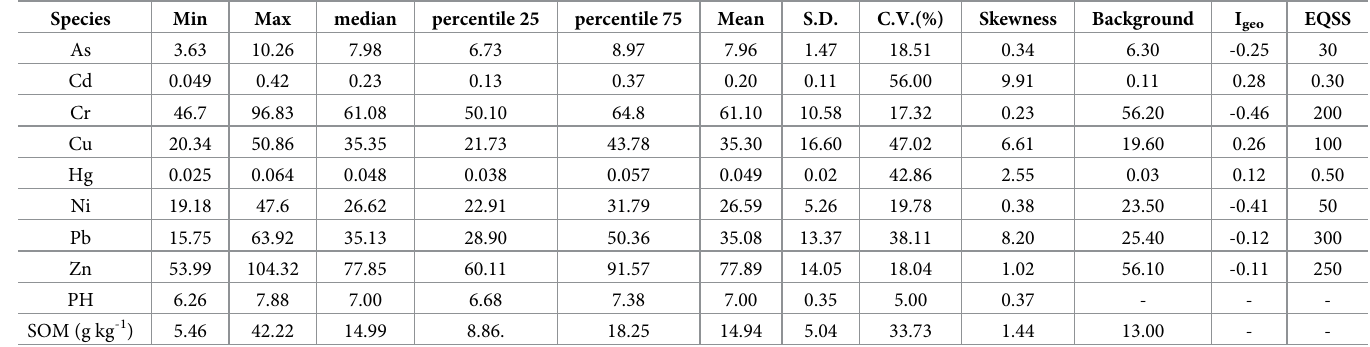
Table 1. Descriptive statistics of potentially toxic elements in the study area (n = 138, units in mg kg -1 ). Species